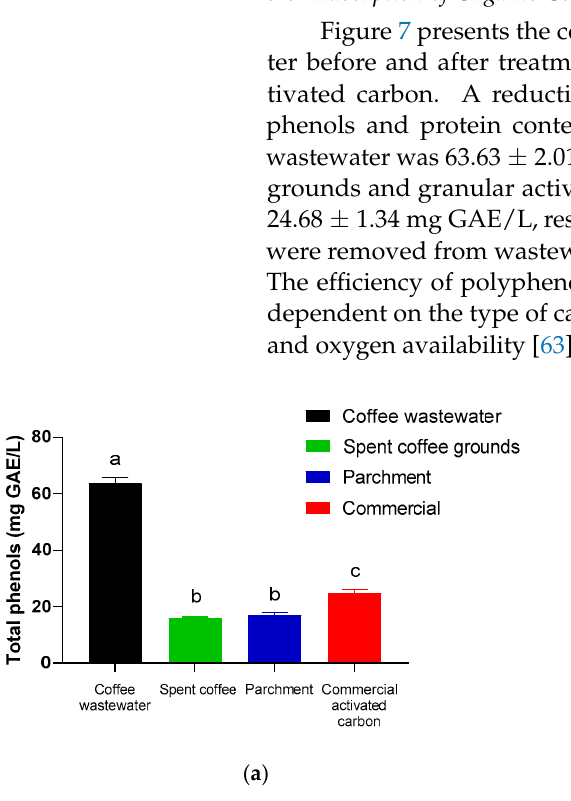
Figure 7. Amount of ( a ) total phenols and ( b ) protein content remaining from the coffee wastewater after their adsorption onto parchment, spent coffee grounds and commercial activated carbons. Adsorbent dose of 10% ( w / v ) and 4 h contact time at room temperature. Data are expressed as means ± standard deviation ( n = 3). Different letters indicate significantly different values for each group (different superscript letters indicate a significant difference, p < 0.05, one-way ANOVA, Tukey’s test).